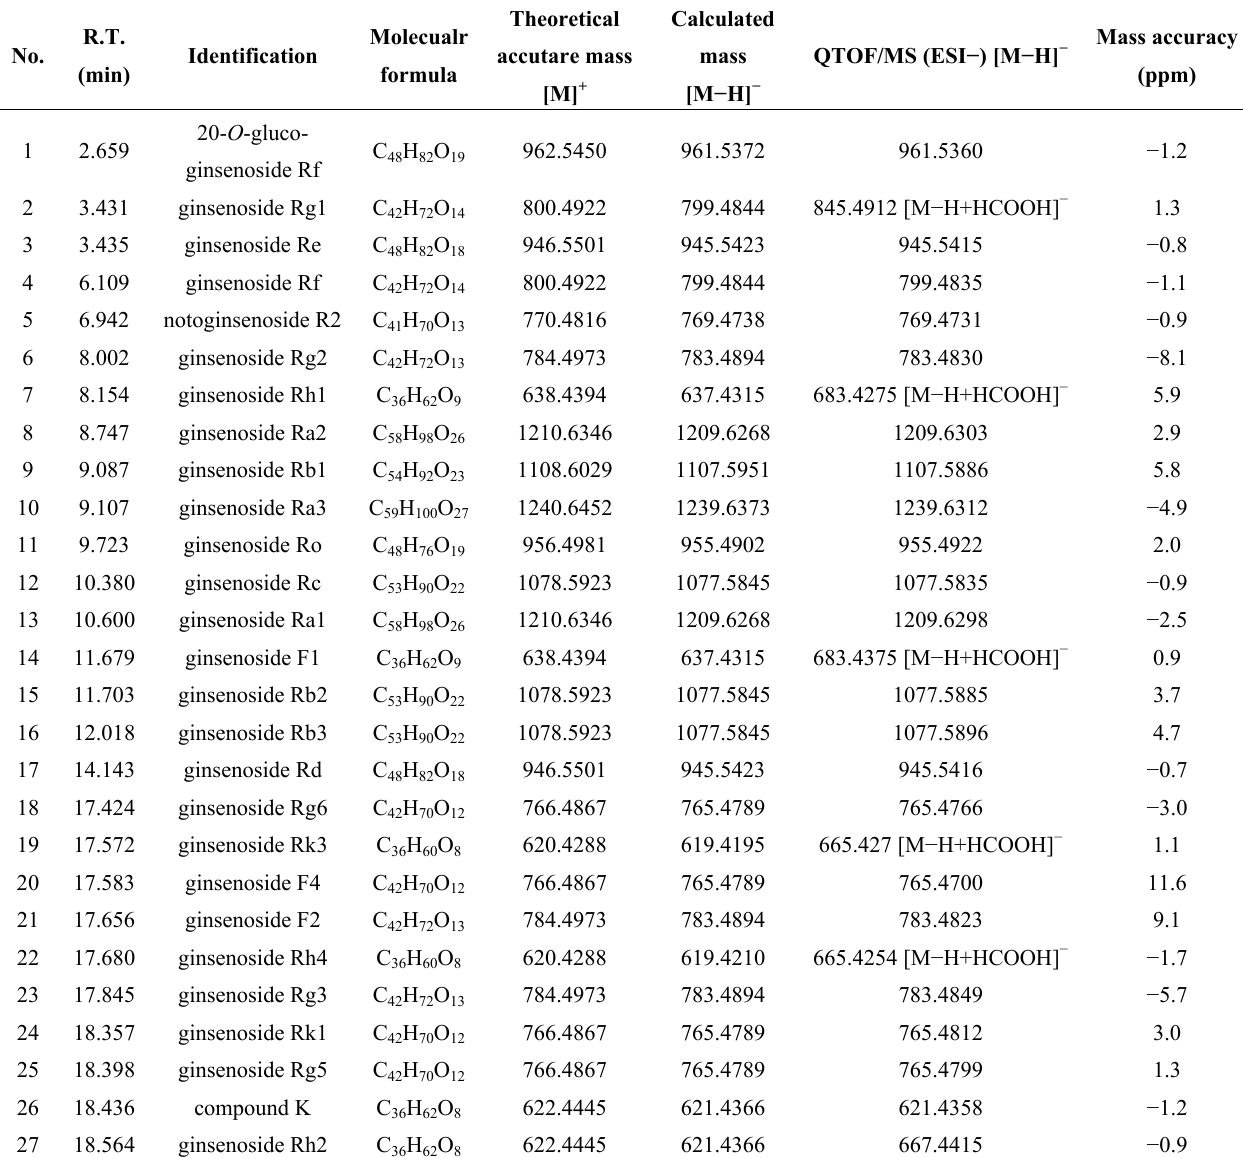
Table 1 . In-house library of ginsenosides isolated from Panax ginseng